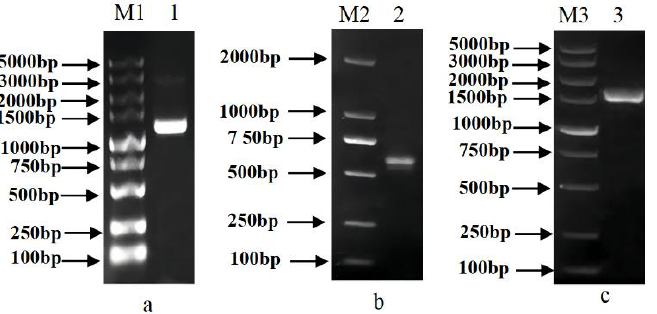
Figure 3. PCR amplification of DoBAM1 of full-length cDNA. ( a ) M1: DL2 000 bp DNA Marker; 1: 5′RACE PCR; ( b ) M2: 2000 bp DNA Marker; 2: 3′RACE PCR; ( c ) M3: DL5 000 bp DNA Marker; 3: ORF full-length PCR.